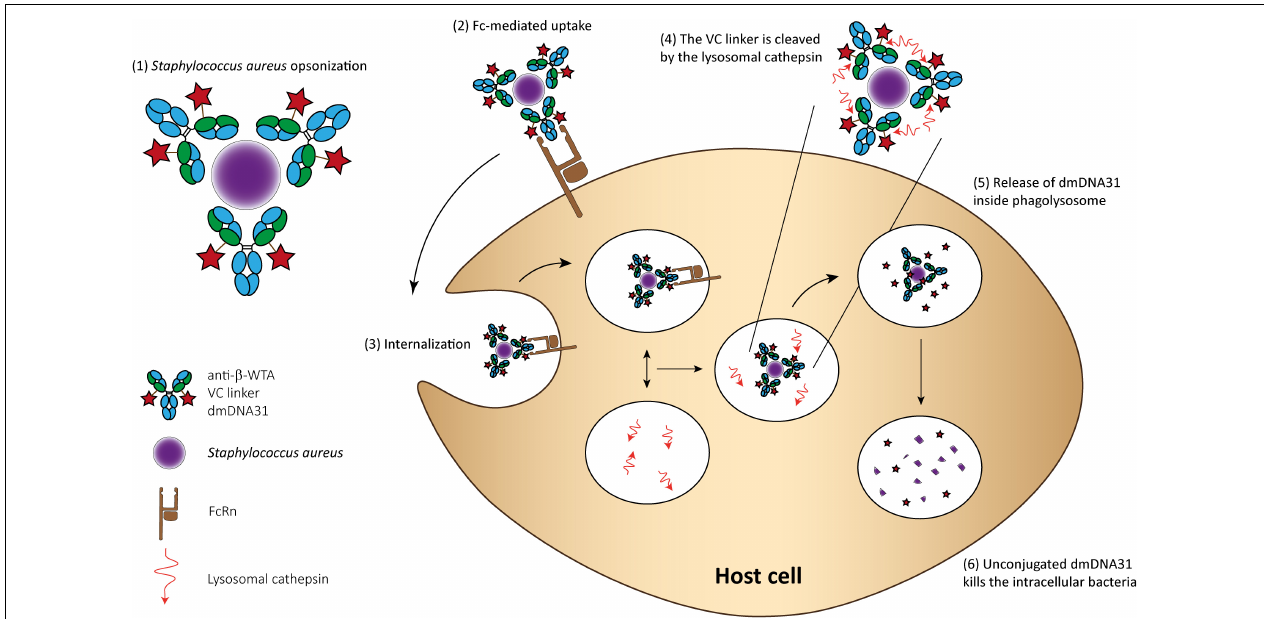
FIGURE 3 | THIOMABTM AAC mechanism of action for killing Staphylococcus aureus. (1) The AAC binds Staphylococcus aureus bacteria; (2) The Fc domain of the monoclonal antibody is recognized by the FcRn on the surface of professional phagocytes or other host cells, such as epithelial cells; (3) The complex is internalized; (4) Fusion between the phagosome and lysosome and cleavage of the VC linker; (5) The active dmDNA31 is released attacking the intracellular bacteria; and (6) Unconjugated dmDNA31 eliminates the intracellular